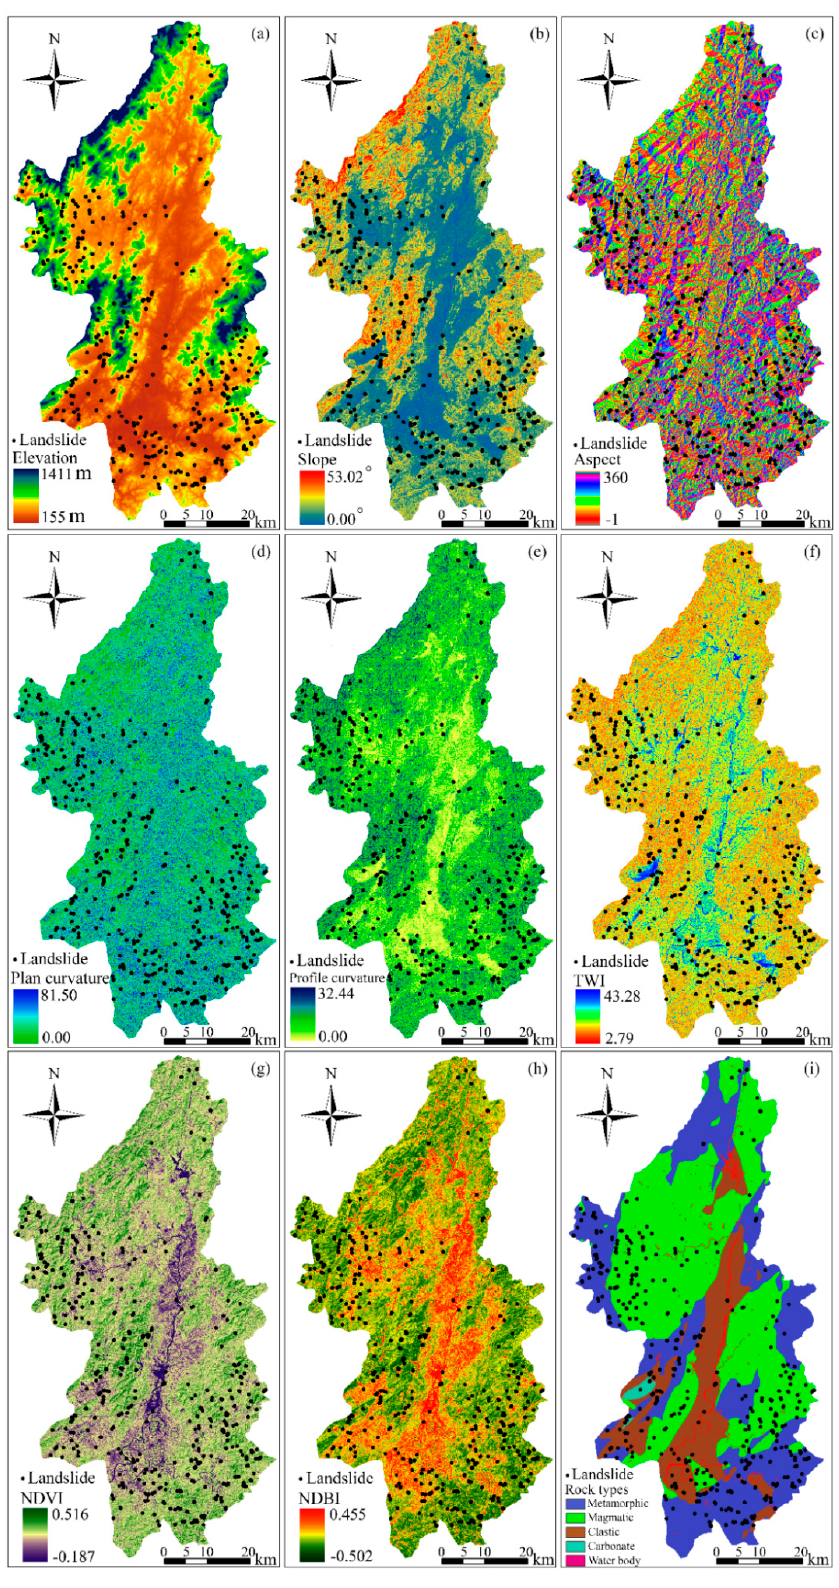
Figure 2. Predisposing factors under 30 m resolution: ( a ) elevation; ( b ) slope; ( c ) aspect; ( d ) plan curvature; ( e ) profile curvature; ( f ) topographic wetness index (TWI); ( g ) normalized difference vegetation index (NDVI); ( h ) normalized difference built-up index (NDBI); ( i ) lithology.